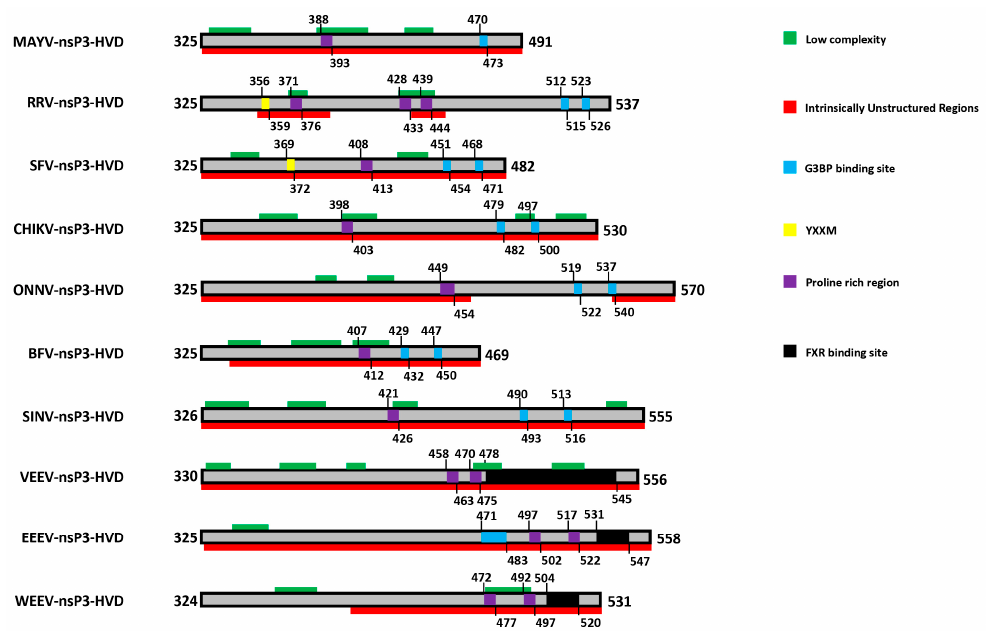
Figure 2. Prominent features in HVD of various alphaviruses. Selected features are displayed with different colors as indicated on the right. For details please see text. Prediction of low complexity regions was carried out using the SEG program [98] and intrinsically unstructured regions were predicted using http://anchor.enzim.hu/ [99]. The Uniprot entries of nsP3 sequences used for the analyses are: MAYV (Q8QZ73), RRV (P13887), SFV (P08411), CHIKV (Q8JUX6), ONNV (Q8QZ73), BFV (P87515), SINV (P03317), VEEV (P36328), EEEV (Q4QXJ8), WEEV (P13896).